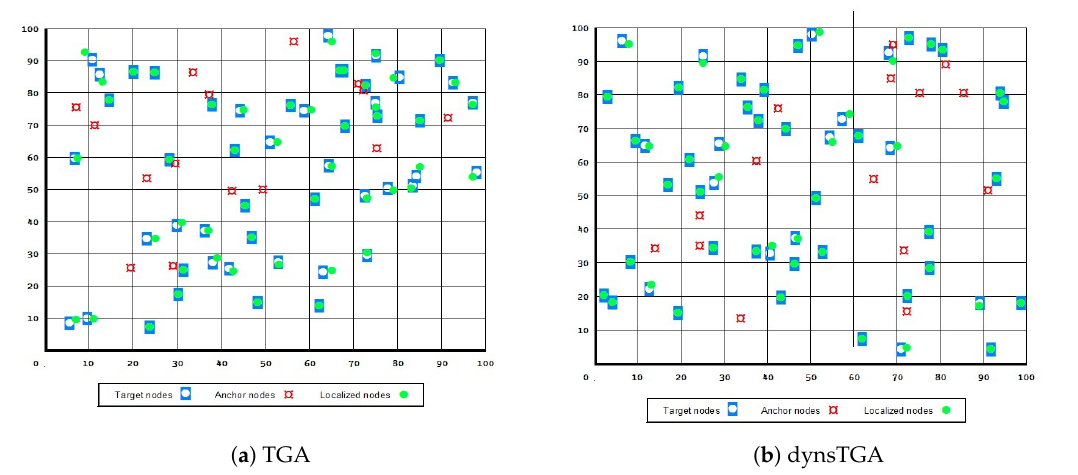
Figure 4. Node localization using original TGA and dynamic